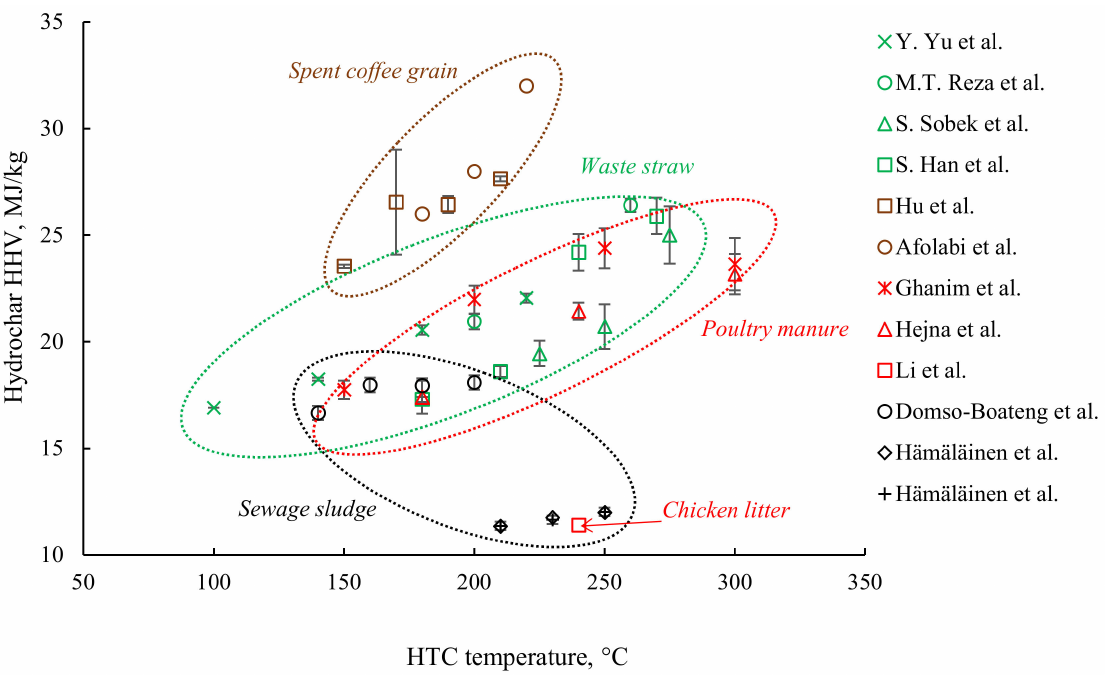
Figure 7. Impact of HTC temperature on straw hydrochars higher heating value and energy yields